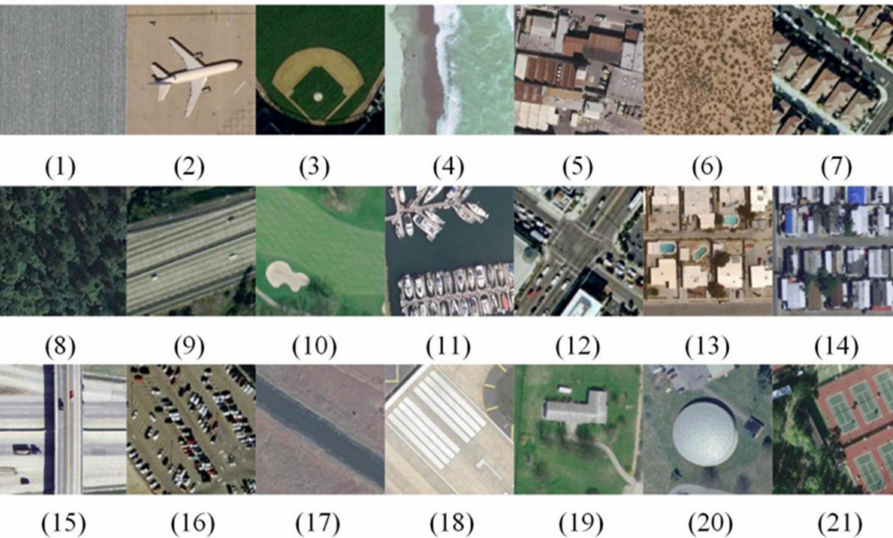
Figure 7. Sample images of each category in the UC-Merced Land Use dataset: (1) agricultural, (2) airplane, (3) baseball diamond, (4) beach, (5) buildings, (6) chaparral, (7) dense residential, (8) forest, (9) freeway, (10) golf course, (11) harbor, (12) intersection, (13) medium residential, (14) mobile home park, (15) overpass, (16) parking lot, (17) river, (18) runway, (19) sparse residential, (20) storage tanks, (21) tennis